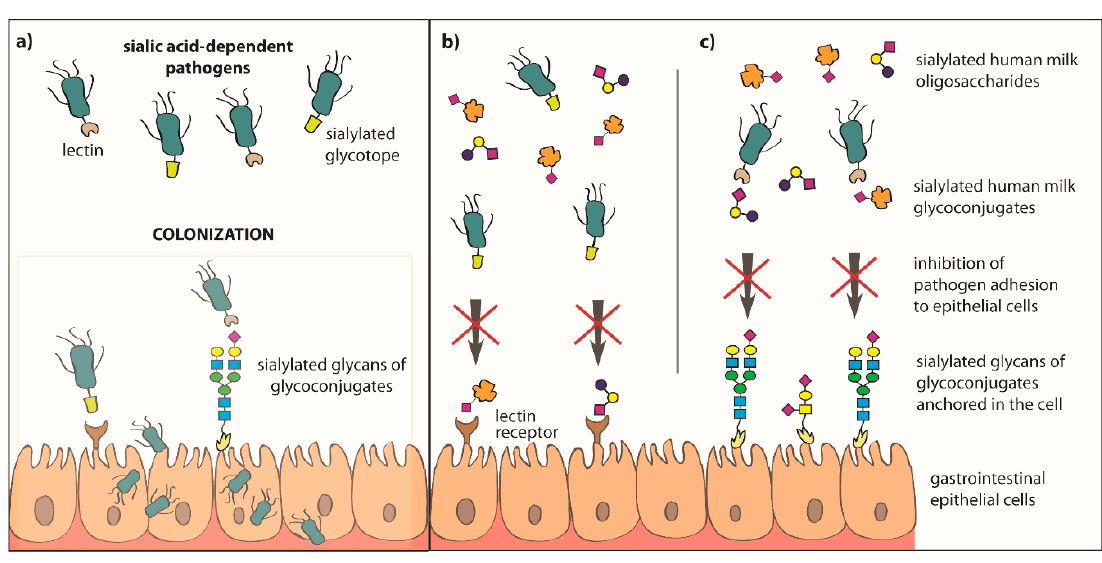
Figure 3. Inhibition of pathogen adhesion to epithelial cells of the newborn’s and infant’s gastrointestinal tract by sialylated oligosaccharides and glycoconjugates of human milk. The possibility of colonization of host epithelial cells by pathogens is called an invasive virulence mechanism, and in this process an important role is played by surface structures of microorganisms, such as lectin receptors and/or glycotopes ( a ). The process of adhesion of microorganisms to the host lectin receptor and/or glycoconjugates can be inhibited by the sialylated human milk oligosaccharides and soluble glycoconjugates, which can be recognized and bound by the lectin receptors of epithelial cells ( b ), and/or are recognized and bound by bacterial lectin receptors ( c ). In both cases, the occurrence of this type of interaction between sialylated oligosaccharides or glycoconjugates of human milk and bacterial lectin receptors and/or host cells leads to the inhibition of pathogen adhesion.